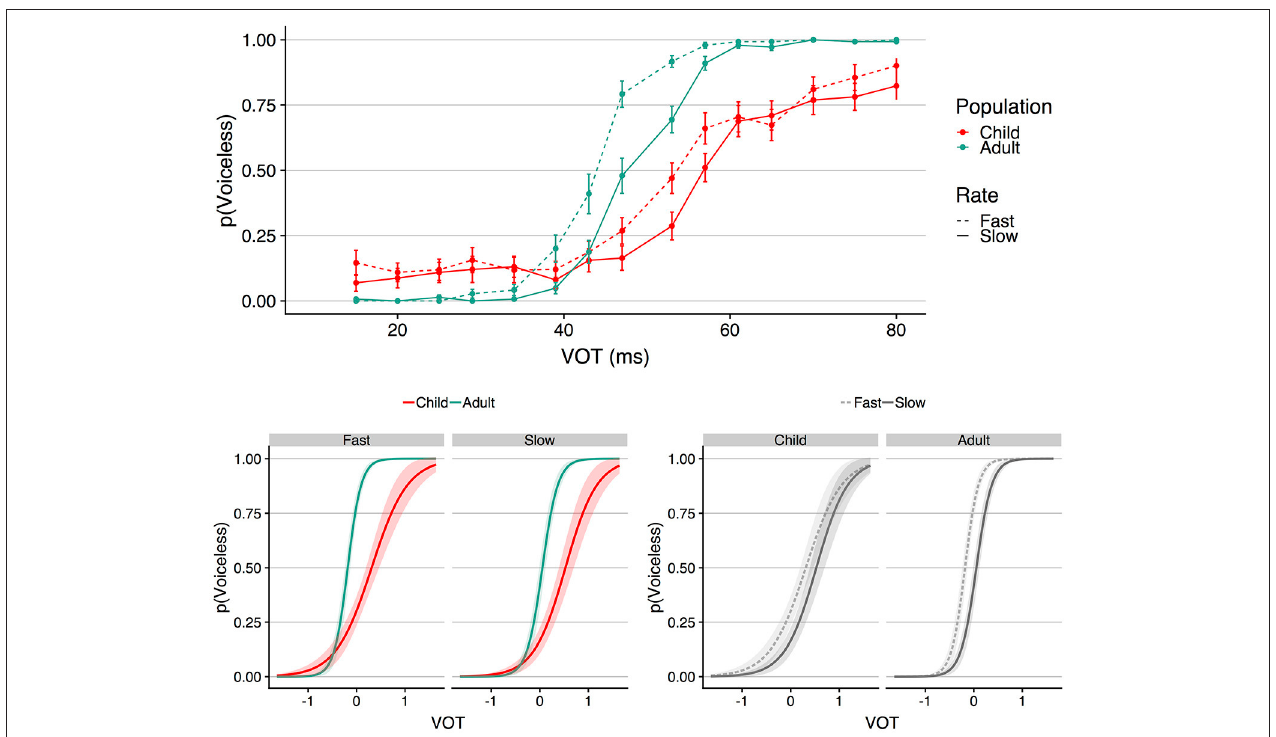
FIGURE 2 | The (Top) shows mean proportion voiceless responses as a function of VOT (ms) for each population at each speaking rate. Error bars indicate standard error of the mean. The (Bottom) shows the results of the GLMM; VOT (in ms) was entered into the model scaled and centered around the mean, which is shown as 0 on the abscissa for the plots on the bottom panel. At left, speaking rate is faceted to facilitate visualization of the interaction between VOT and population. At right, population is faceted to facilitate visualization of the speaking rate effect in each population. The shaded regions around the functions in the bottom panel indicate the 95% confidence interval